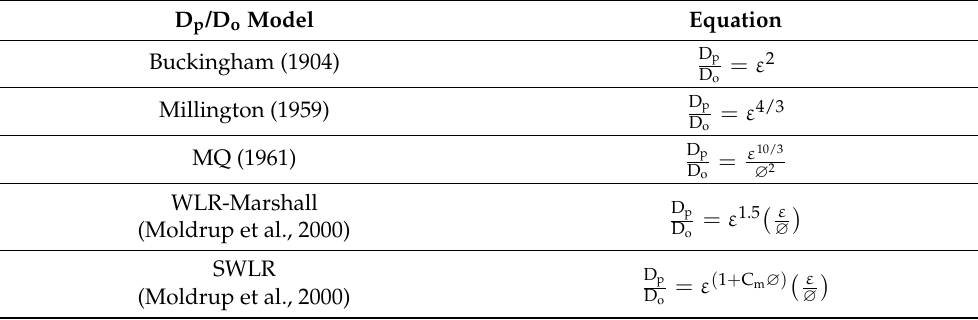
Table 2. Selected predictive soil-gas diffusivity models used in this